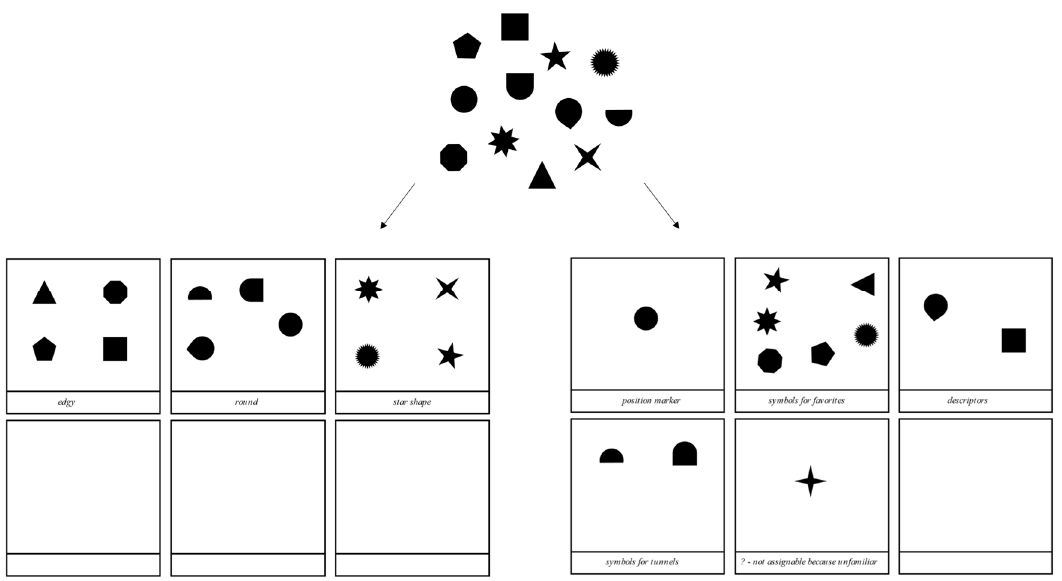
Figure 2. Illustration of two visual protocols from two participants, after completing free-sorting task 1 and free-labeling task 3.